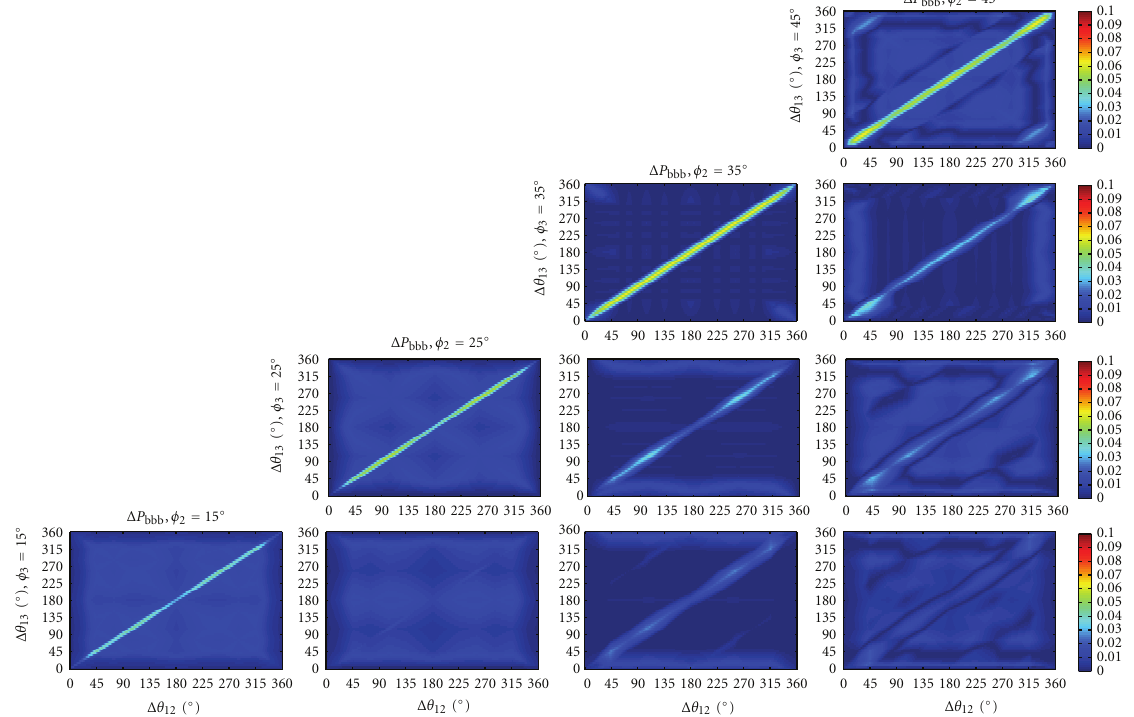
Figure 12: Di ff erence between measured and resimulated “bad bad bad” state probability ( Δ P bbb ) for di ff erent elevation angles ( φ 2 and φ 3 ) and azimuth angle separations ( θ 12 and θ 13 ) of two slave satellites. The master elevation is constant at φ 1 = 45 ◦